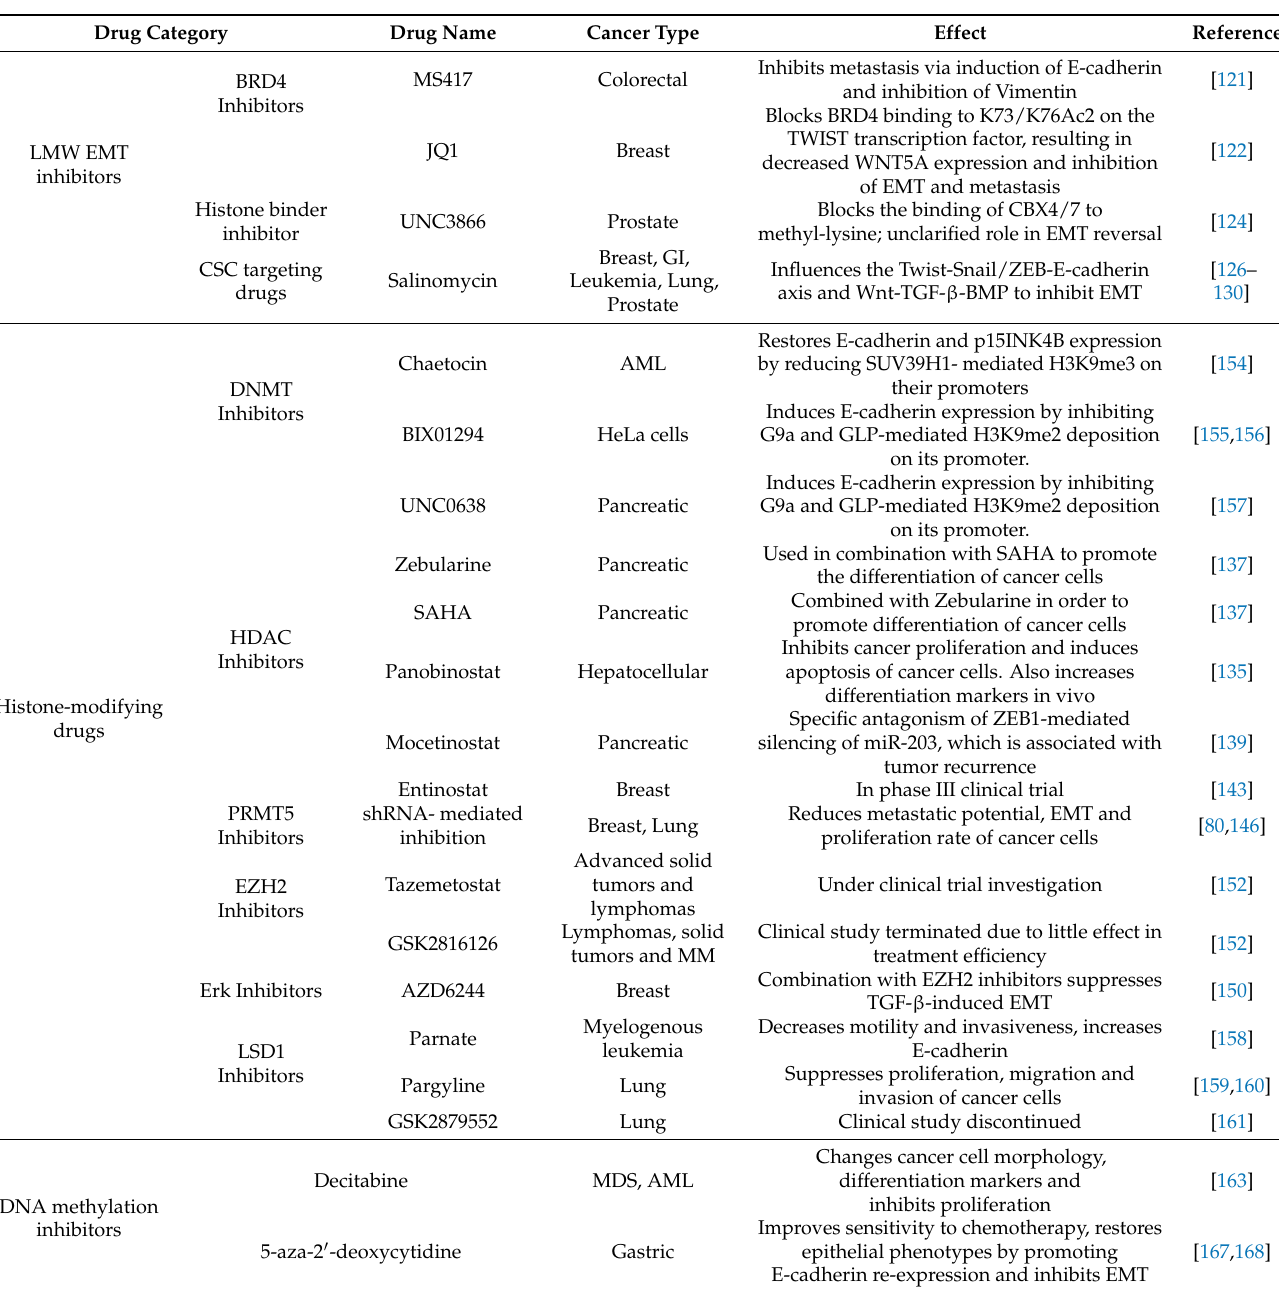
Table 1. Drug targeting of histone